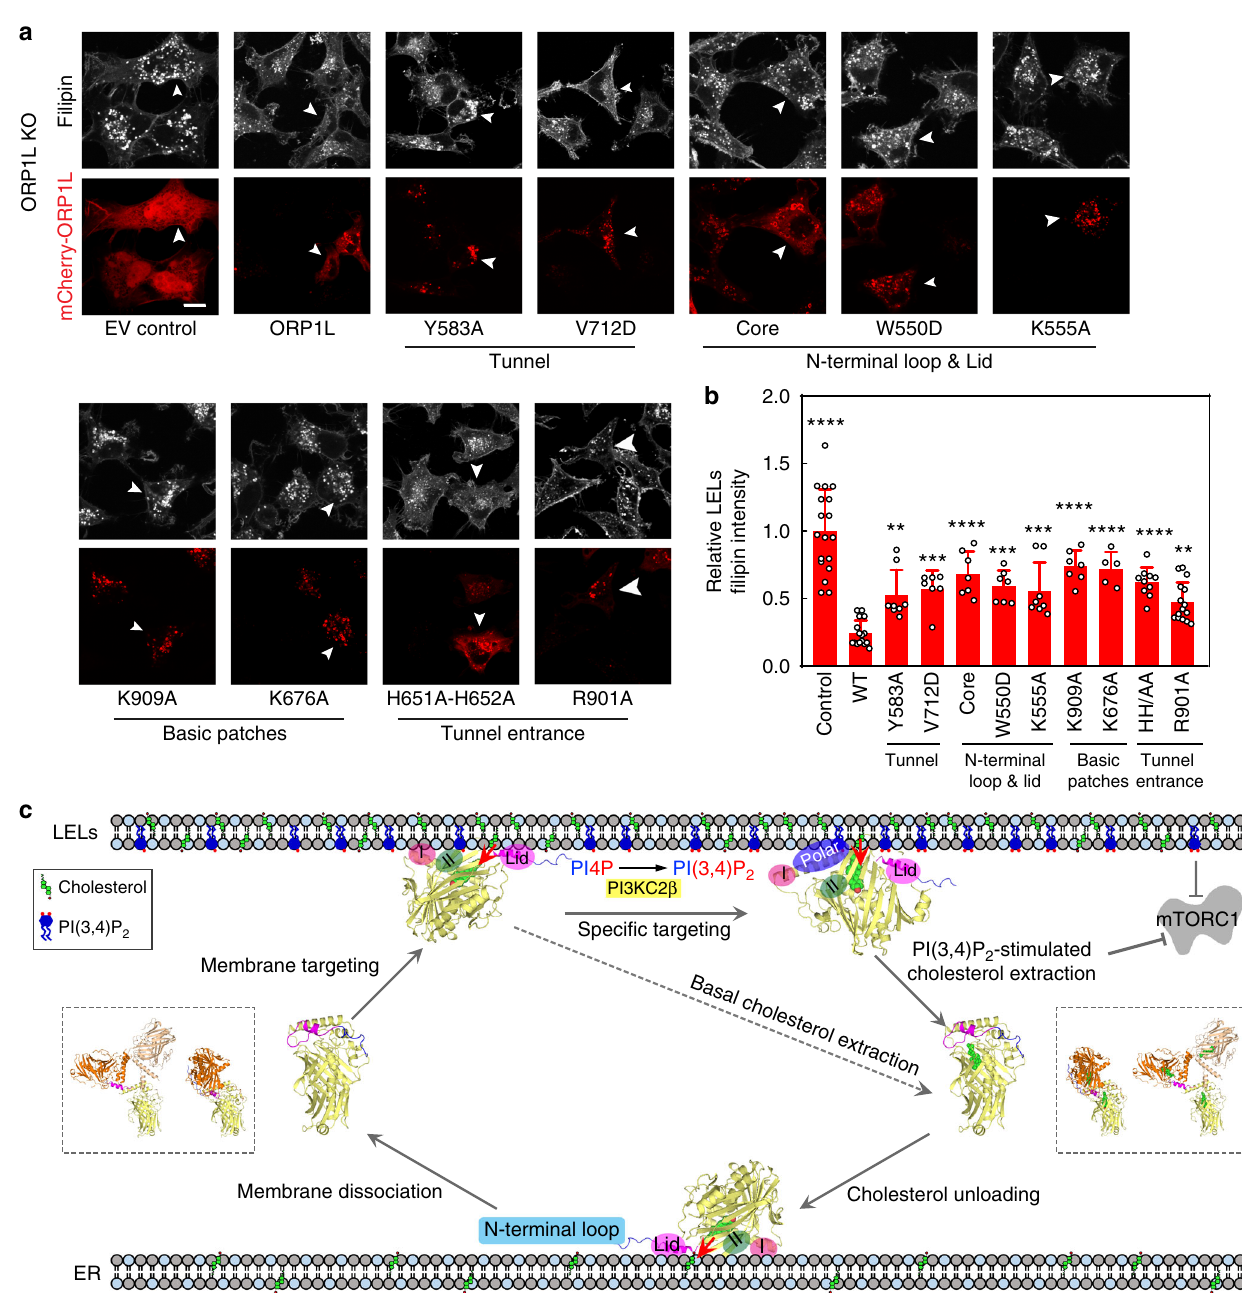
Fig. 9 PI(3,4)P 2 /PI(4,5)P 2 allosterically stimulates ORP1 function. a Lysosomal cholesterol release assay in ORP1L KO cells overexpressing ORP1L mutants (scale bar = 10 μ m). b Quantitation of LELs fi lipin intensities of transfected cells in a (data are shown as mean ± s.d. (error bar); n = 5 – 15). c Working model for PI(4,5)P 2 /PI(3,4)P 2 -stimulated cholesterol transport by ORP1-ORD. The red arrows indicate the orientations of lipid-binding tunnel to